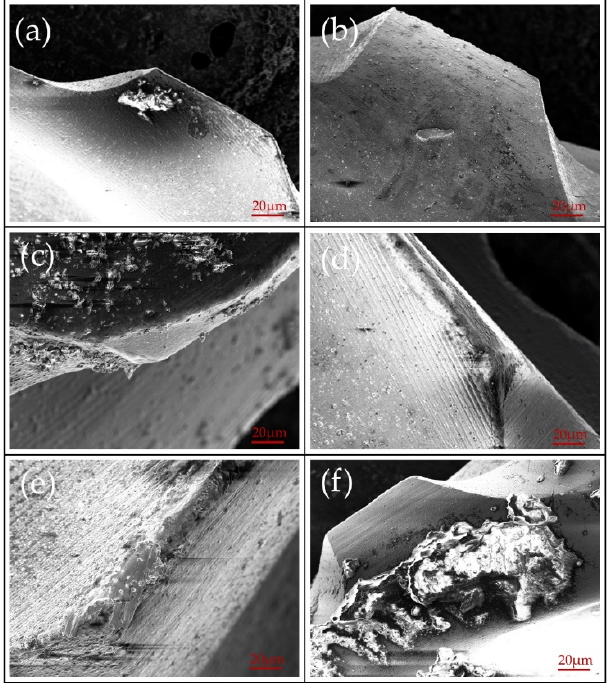
Figure 17. Micromorphology of coated milling cutters with different milling parameters: ( a ) Rev: 42,000 rpm; Vf: 2 mm/s; ( b ) Rev: 42,000 rpm; Vf: 4 mm/s; ( c ) Rev: 42,000 rpm; Vf: 8 mm/s; ( d ) Rev: 38,000 rpm; Vf: 2 mm/s; ( e ) Rev: 38,000 rpm; Vf: 4 mm/s; ( f ) Rev: 38,000 rpm; Vf: 8 mm/s.